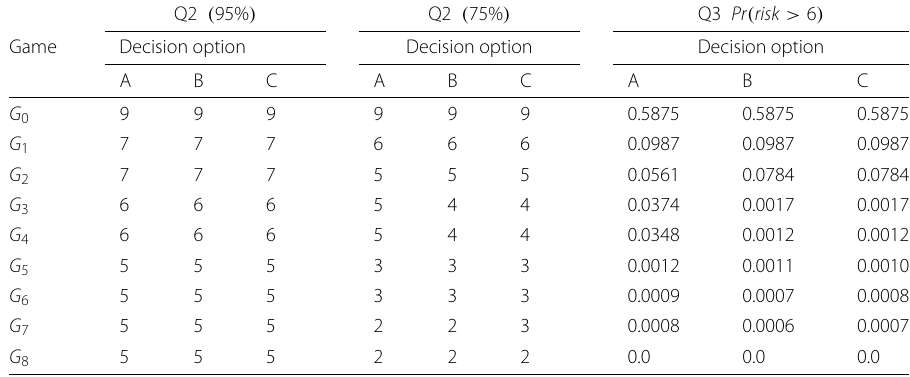
Table 4 Statistical quantities of the equilibrium risk distributions of all decision-support games Q2 ( 95% ) Q2 ( 75% ) Q3 Pr ( risk > 6